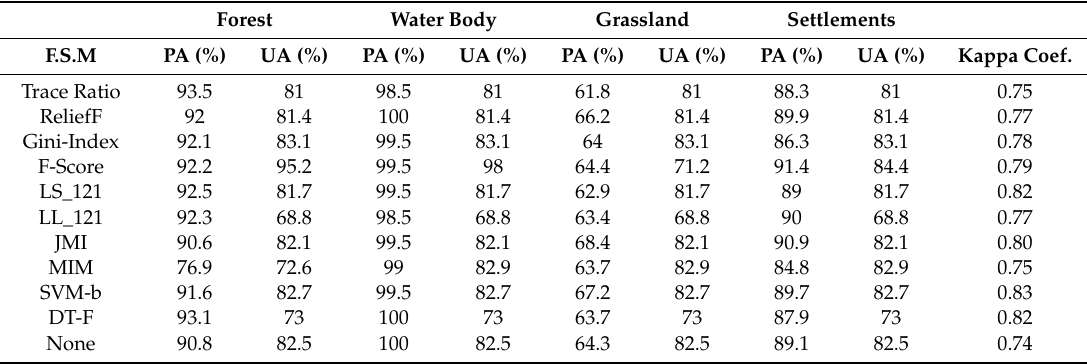
Table 7. Classification accuracies of other classes using optimal feature subsets yielded by investigated feature selection methods for third training set.